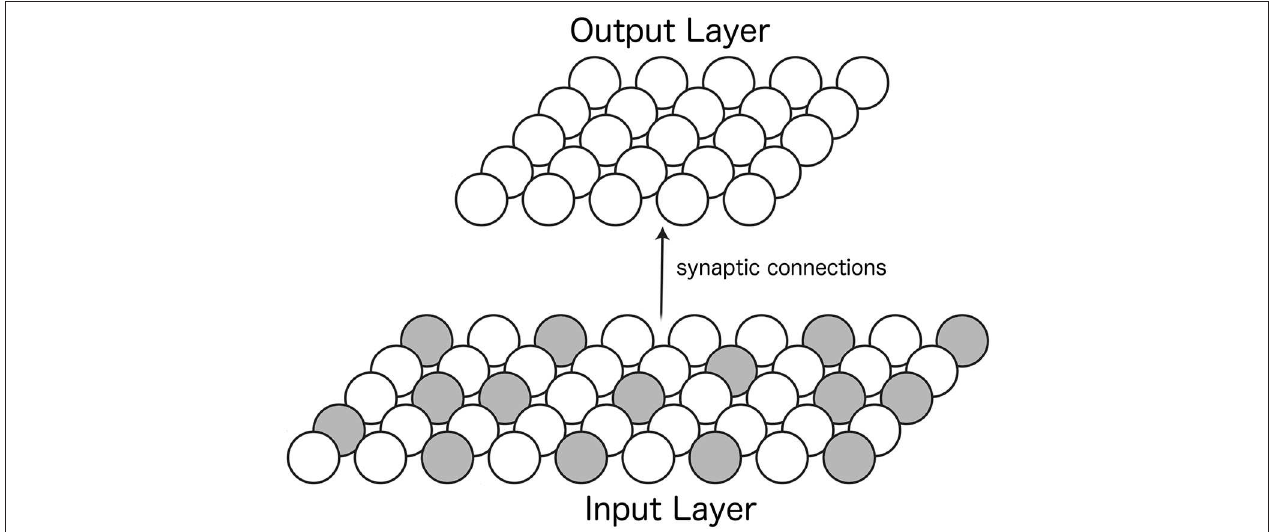
FIGURE 5 | Architecture of the self-organizing neural network model. Afferent synaptic connections from neurons in the input layer (Bottom) are projected to neurons in the output layer (Top) . The responses of neurons within the input layer depend on either the position of the eye or the retinal location of the visual stimulus. The two colors of neurons in the input layer represent these two different forms of neuronal input responses. A Hebbian learning rule is used to modify the strengths of the feedforward synaptic connections from the input layer to the output layer during